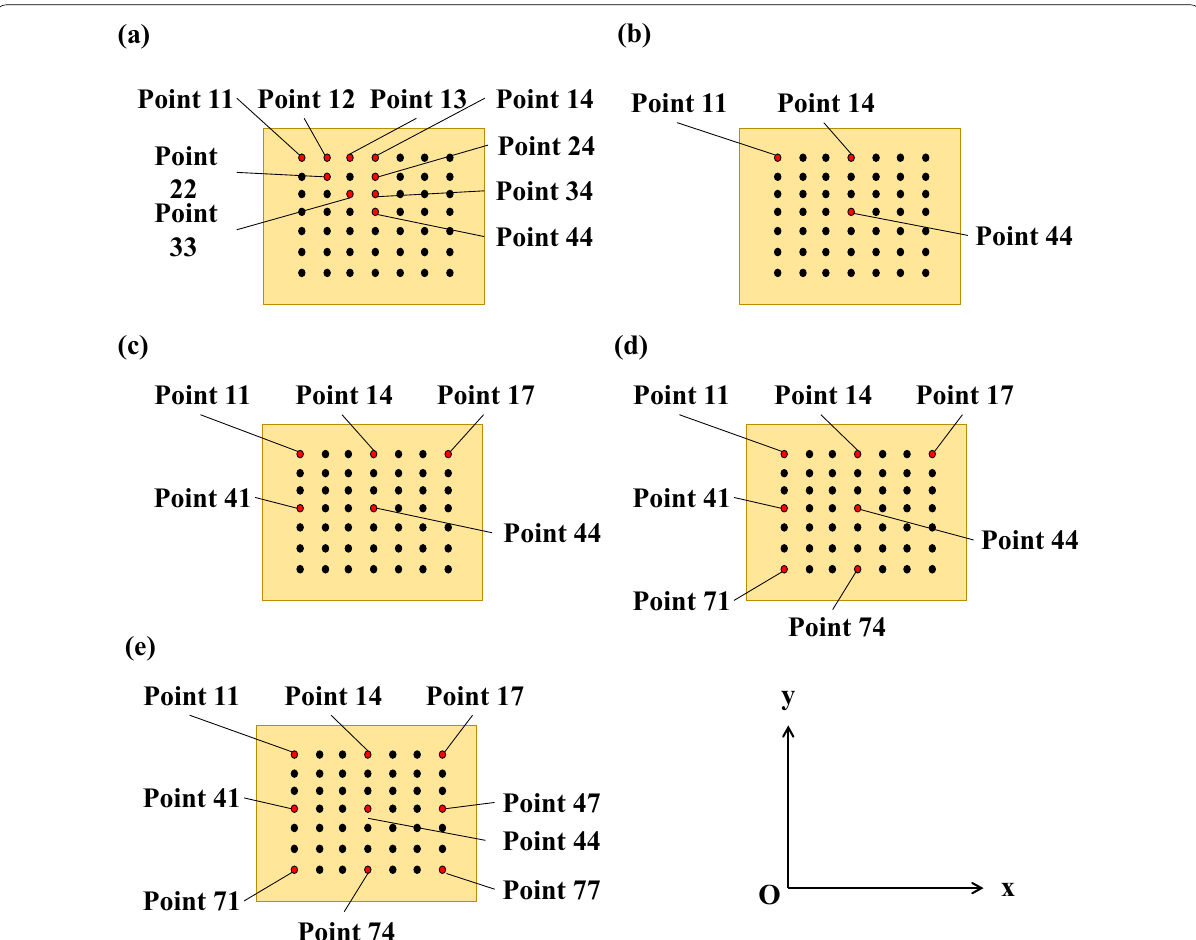
Table 1 lists the mean localization errors for all the